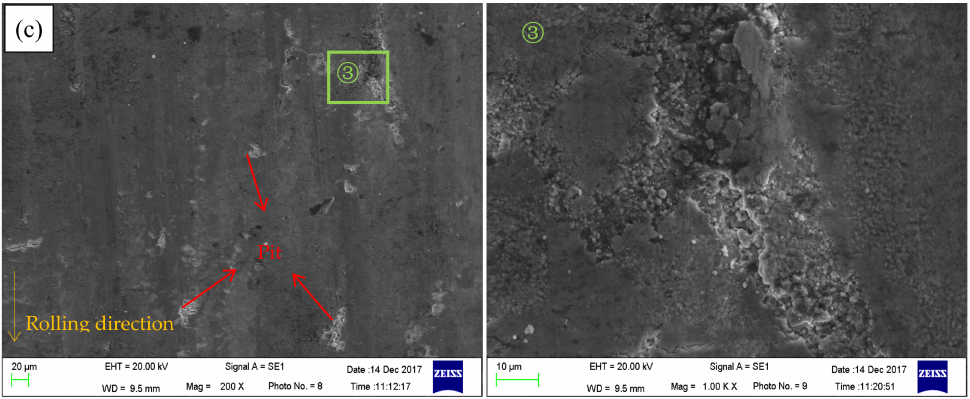
Figure 5. SEM images of hot-rolled surfaces lubricated with ( a ) non-lubricant; ( b ) traditional lubricating fluid and ( c ) nano-TiO 2 fluid.